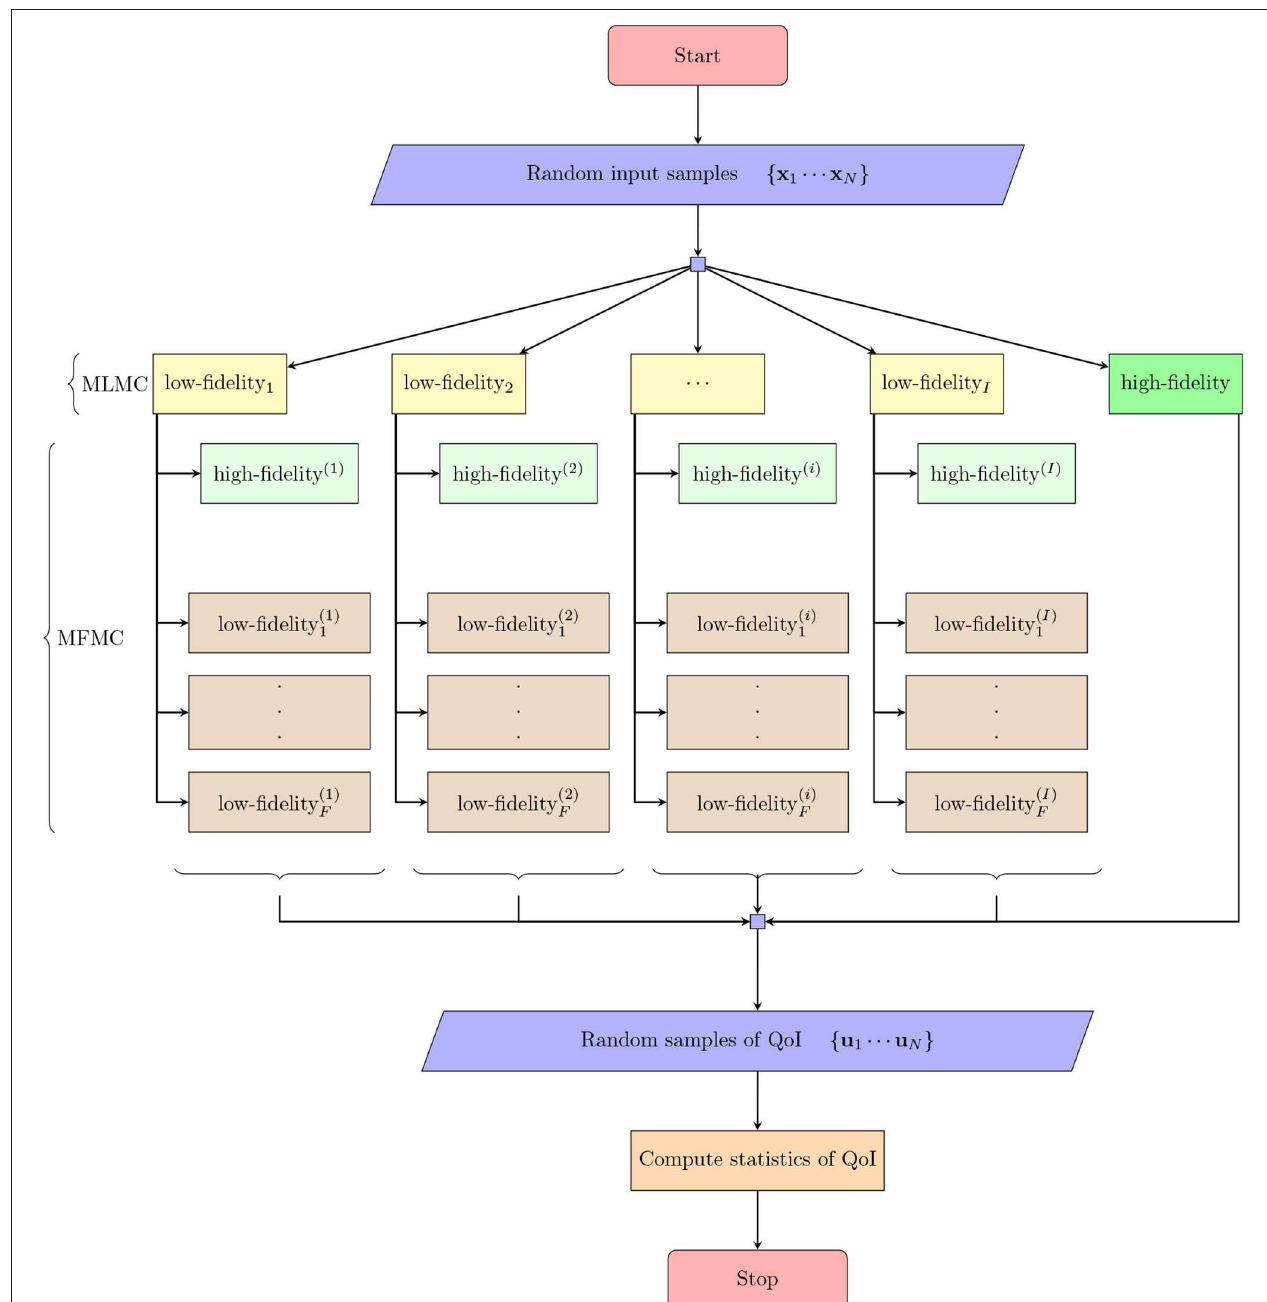
I ) in MLMC setup. The 1,2, = ···